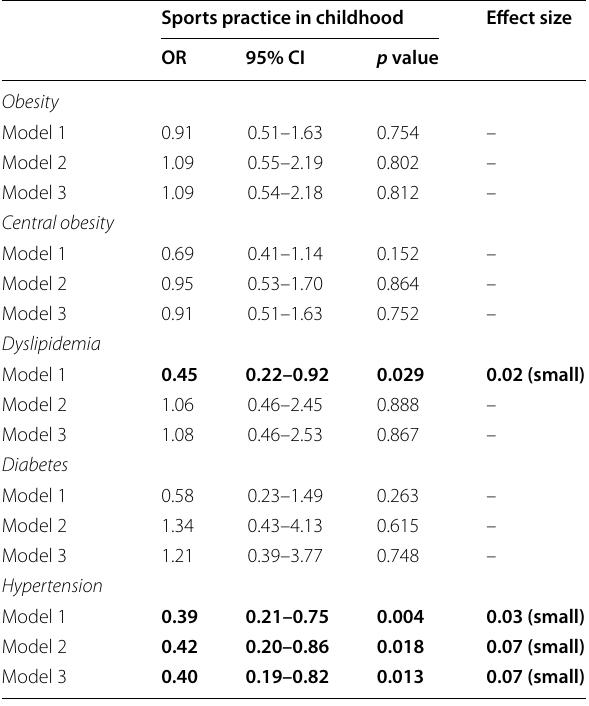
Table 2 Association between early sports practice in childhood and cardiovascular risk factors in adulthood ( n